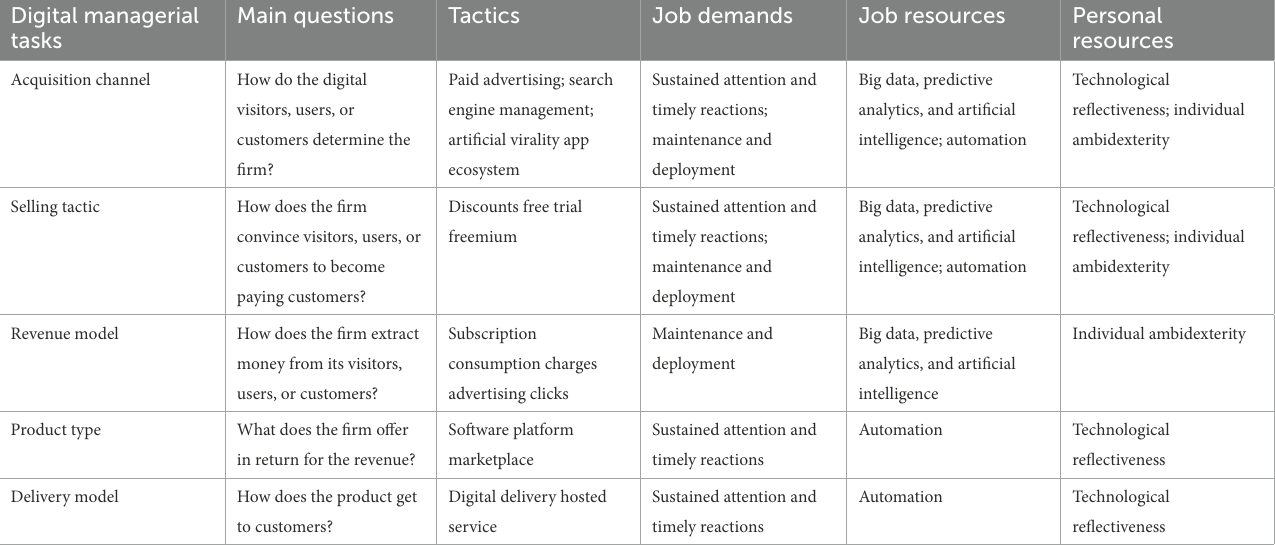
TABLE 1 Linking digital business model tasks with the new job demands and resources. Digital managerial